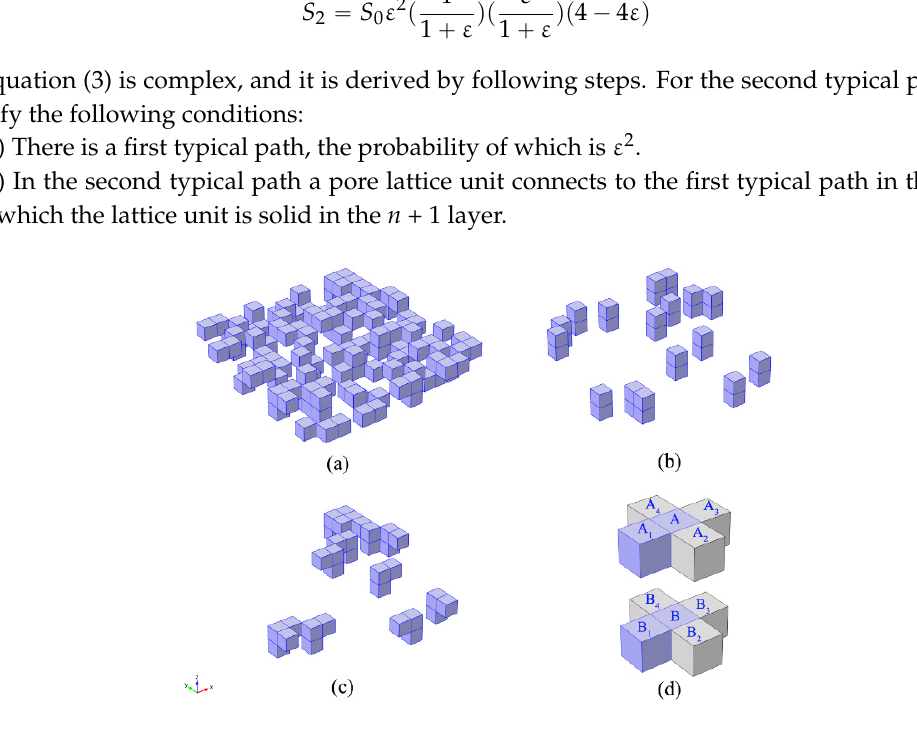
Figure 2. Sketch map for the derivation of the S 1 and S 2 : ( a ) schematic of the location relationship among pores in the two arbitrary adjacent layers; ( b ) schematic of the first typical path; ( c ) schematic of the second typical path; ( d ) schematic of the lattice units connecting to the first typical path. A pore lattice unit in the first typical path contacts with four lattice units in the n or n + 1 layer, which are labeled as A 1 , A 2 , A 3 and A 4 (B 1 , B 2 , B 3 and B 4 ) in the n ( n + 1) layer respectively, as displayed